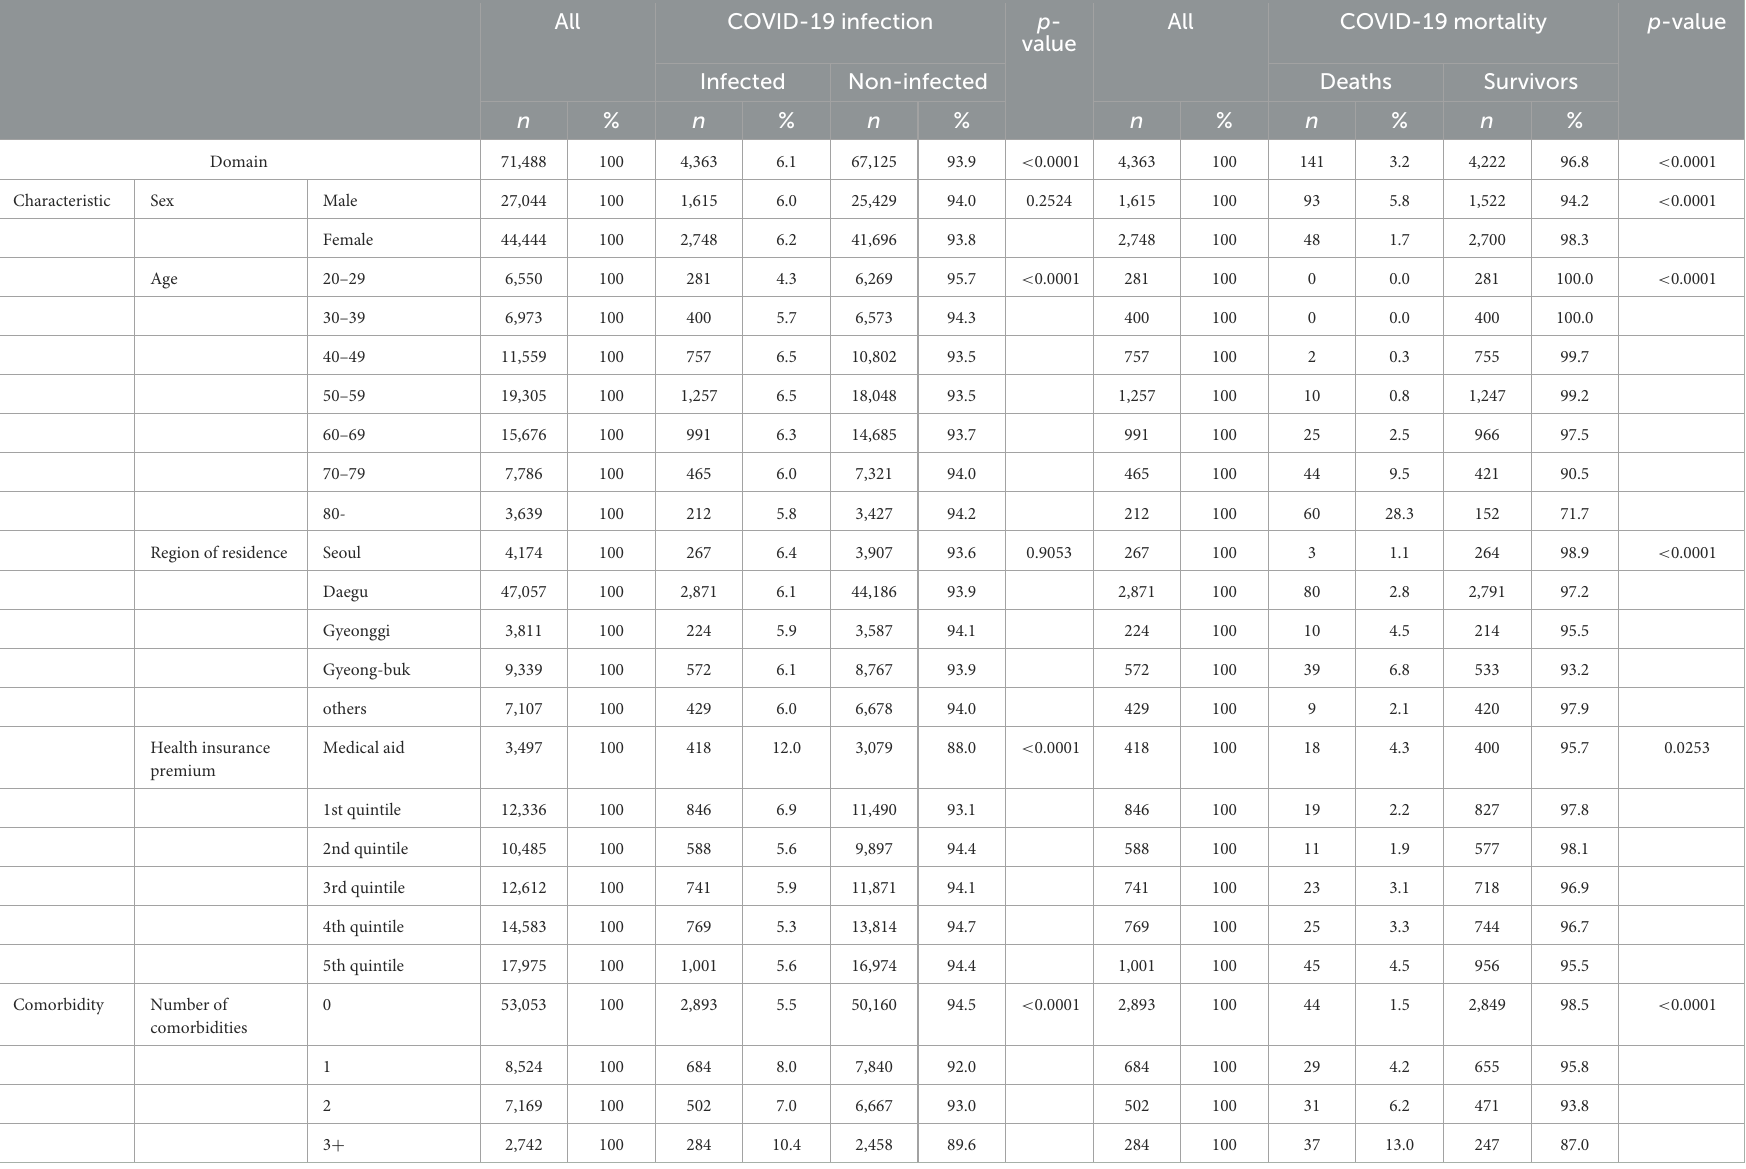
TABLE 1 Descriptive statistics of COVID-19